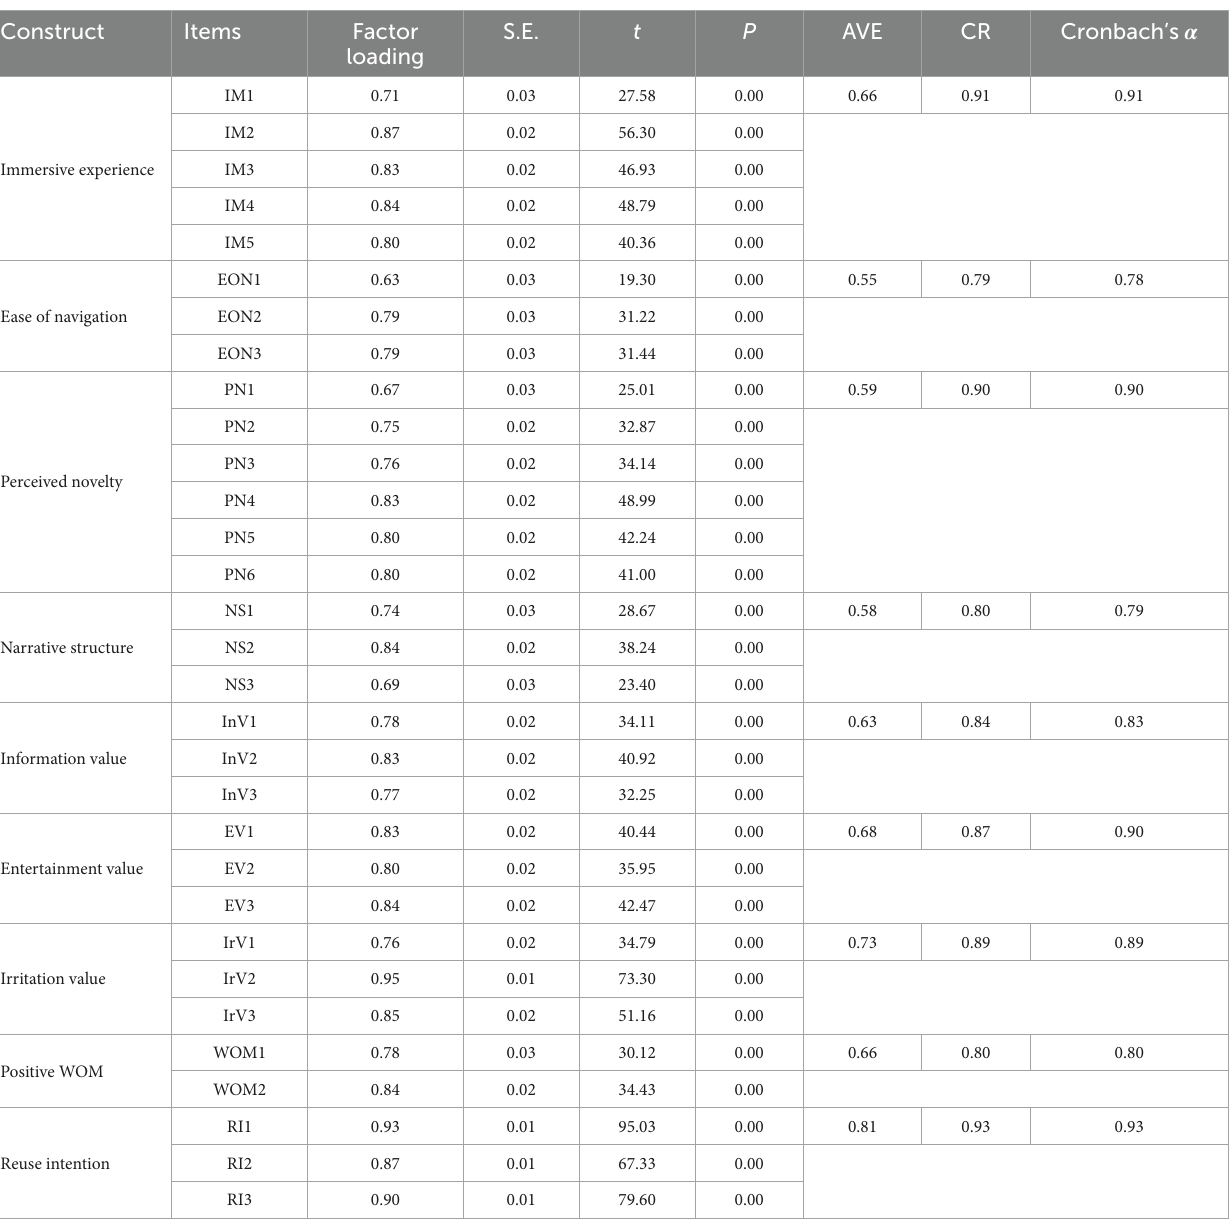
TABLE 3 Convergent validity and reliability statistics.